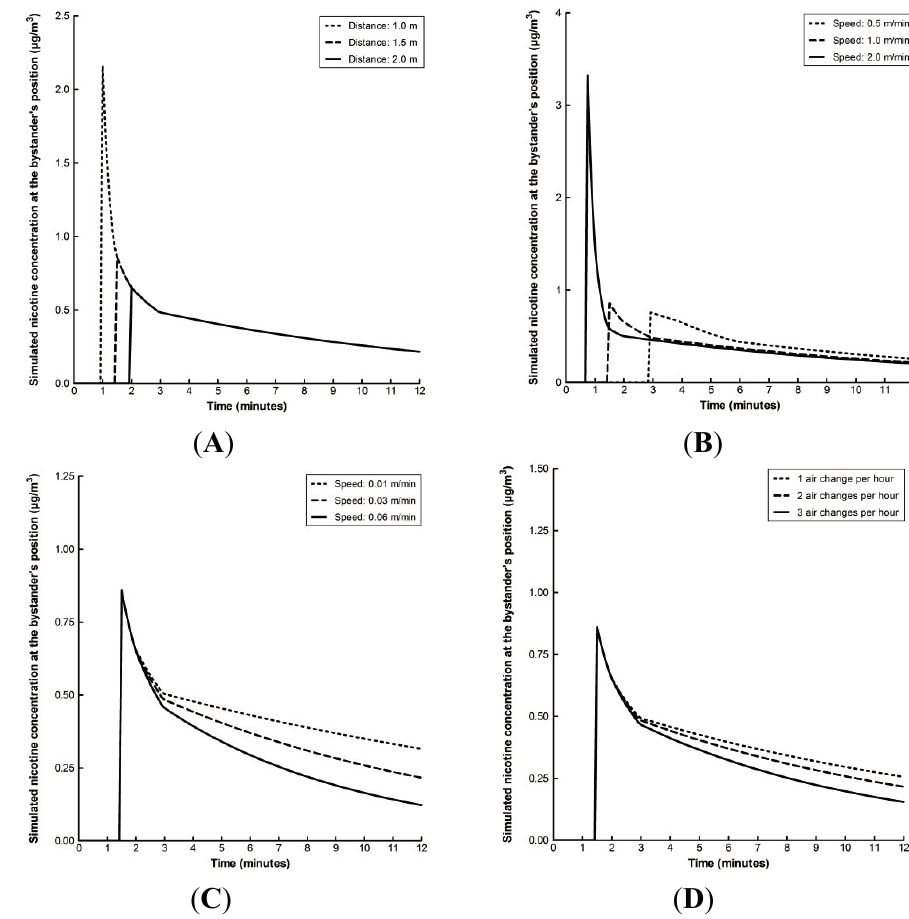
Figure 2. The effect of varying the value of one model input parameter one-at-a-time whilst all others remain constant. The effect of changing the distance of the bystander from the e-cigarette user from 1, 1.5 and 2 m ( A ); speed of exhaled aerosol propagation from 0.5, 1.0 and 2.0 m/min ( B ); exhaled aerosol speed of deposition from 0.01, 0.03 and 0.06 m/min ( C ); and air exchange rate from 1, 2 and 3 air changes per hour ( D ) on the simulated concentration of nicotine in the ambient air at the bystander’s position. When the model parameter value was not varied, it was fixed at the median value. In each case: distance from e-cigarette user, 1.5 m; quantity of nicotine exhaled, 20 µg per puff; speed of exhaled aerosol propagation, 1.0 m/min; exhaled aerosol deposition velocity 0.03 m/min; and air exchanges per hour,